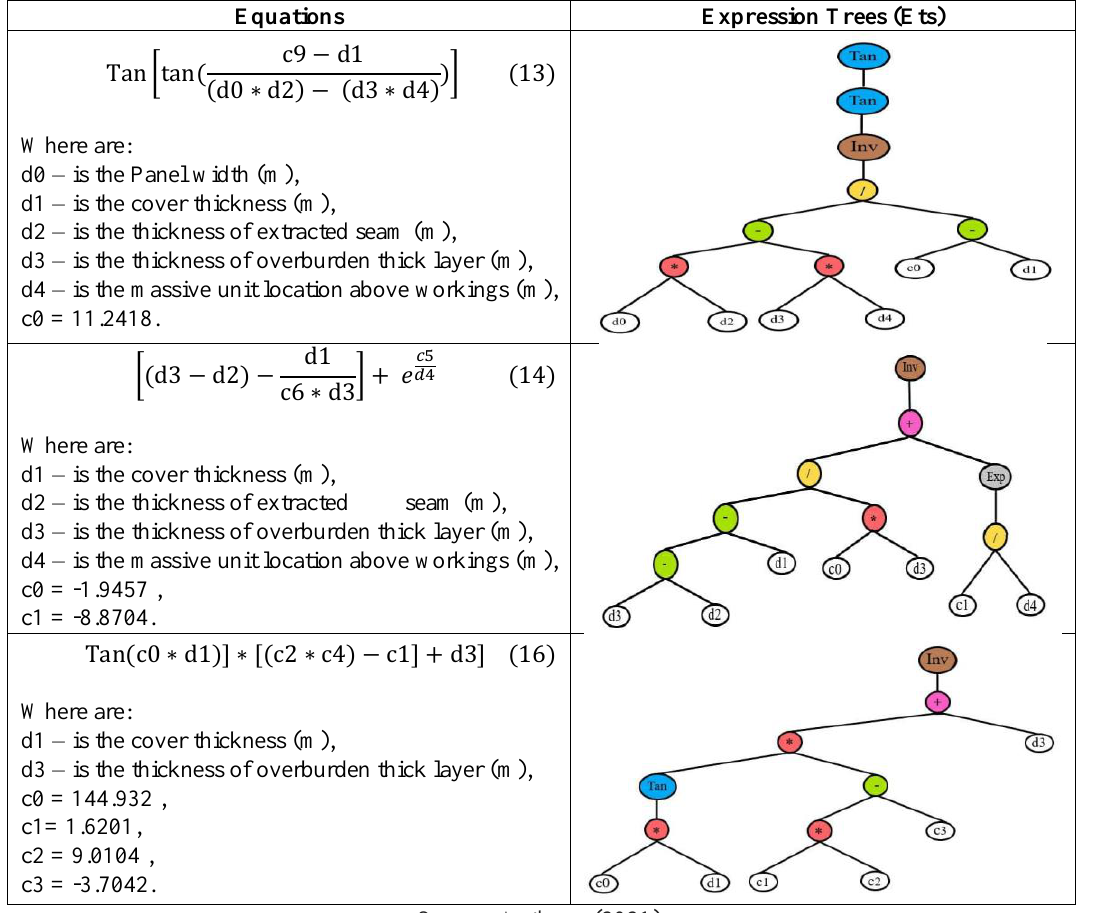
Table 6: Sub-equations and sub-trees of the proposed GEP model